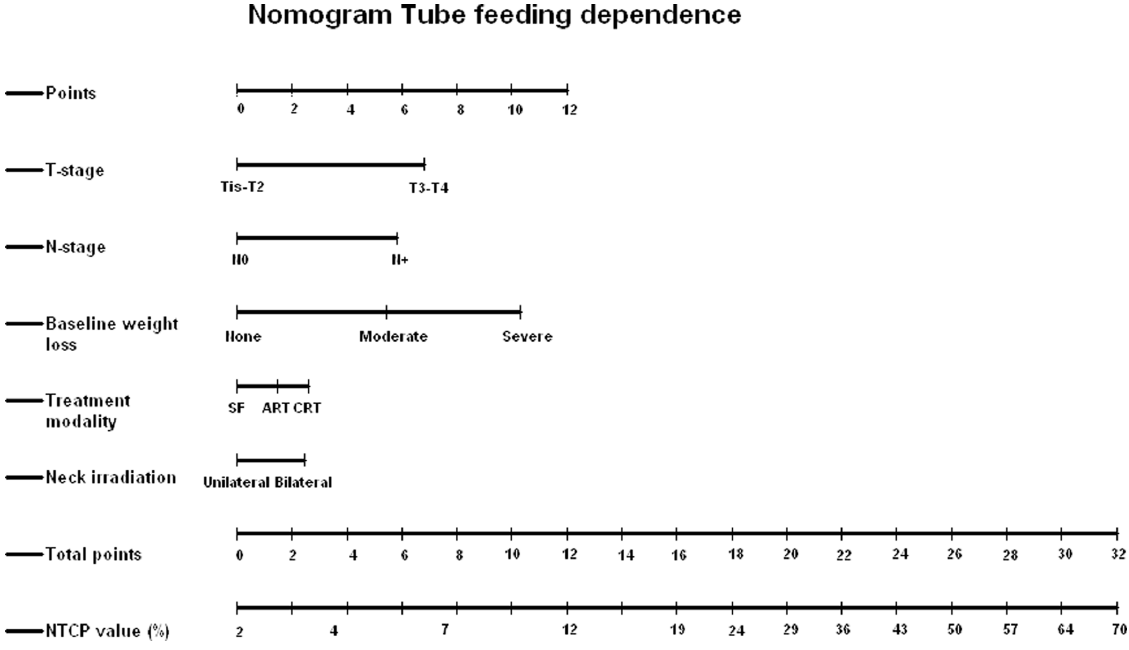
Figure 1. Nomogram for tube feeding dependence to determine normal tissue complication probability (NTCP) values for each individual patient. Abbreviations: SF, conventional radiotherapy; ART, accelerated radiotherapy; CRT,